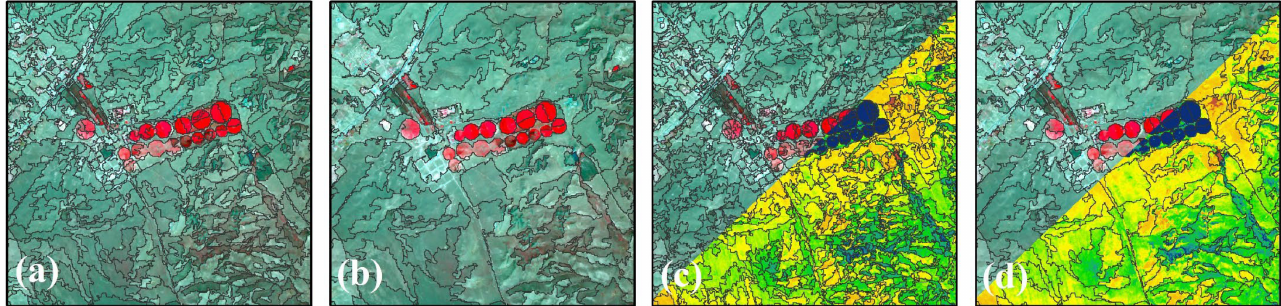
Figure 2. Image segmentation at different scales and input layers: ( a ) segmentation at a scale value of 30 with the multispectral band; ( b ) segmentation at a scale value of 50 with the multispectral band; ( c ) segmentation at a scale value of 30 in combination with the multispectral band and NDVI; ( d ) segmentation at scale value of 50 in combination with the multispectral band and